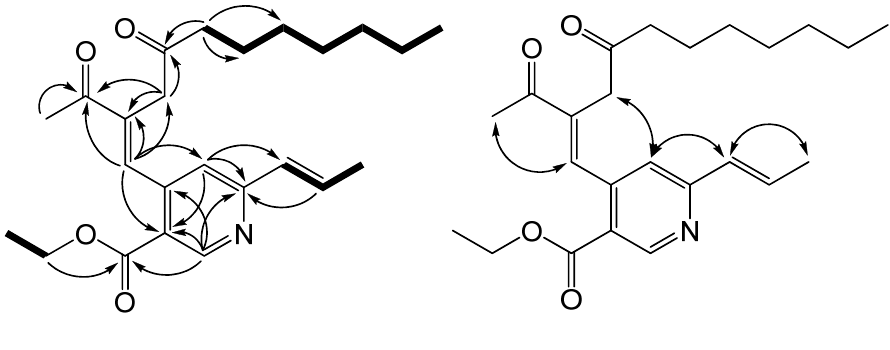
Figure 2. Key 1 H- 1 H COSY ( ▬ ), HMBC (H → C) and NOESY (H ↔ H) correlations of MPA